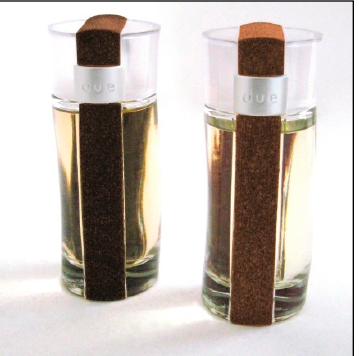
Figure 12. Containers for a perfume moulded using curauá fibre/wood flour based composites [113].